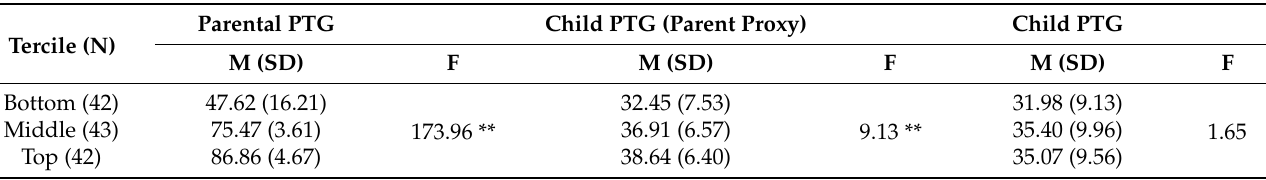
Table 3. Descriptive statistics for parental PTG